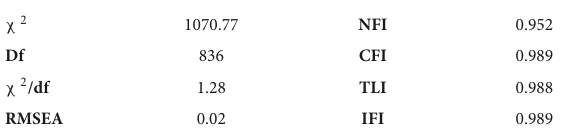
TABLE 6 Path estimates and testing of